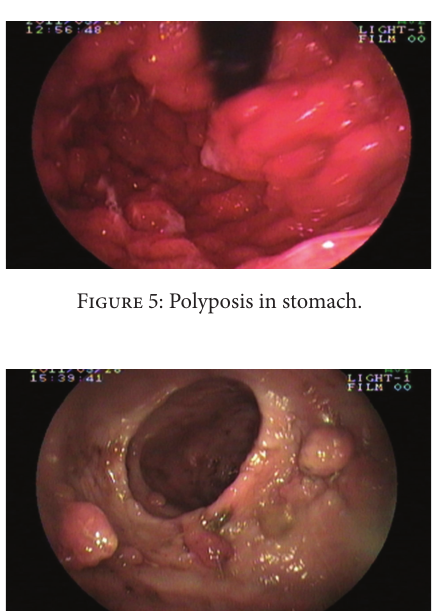
Figure 6: Double lumen enteroscopy showing diffuse polyposis in small intestine.